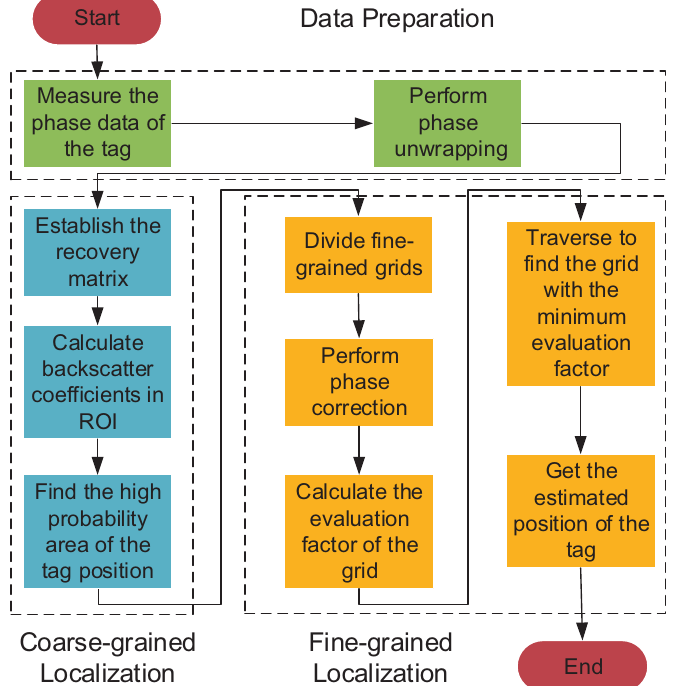
Figure 1. The flow chart for RF-SML system. The algorithm consists of three parts: the data preparation, the coarse-grained localization, and the fine-grained